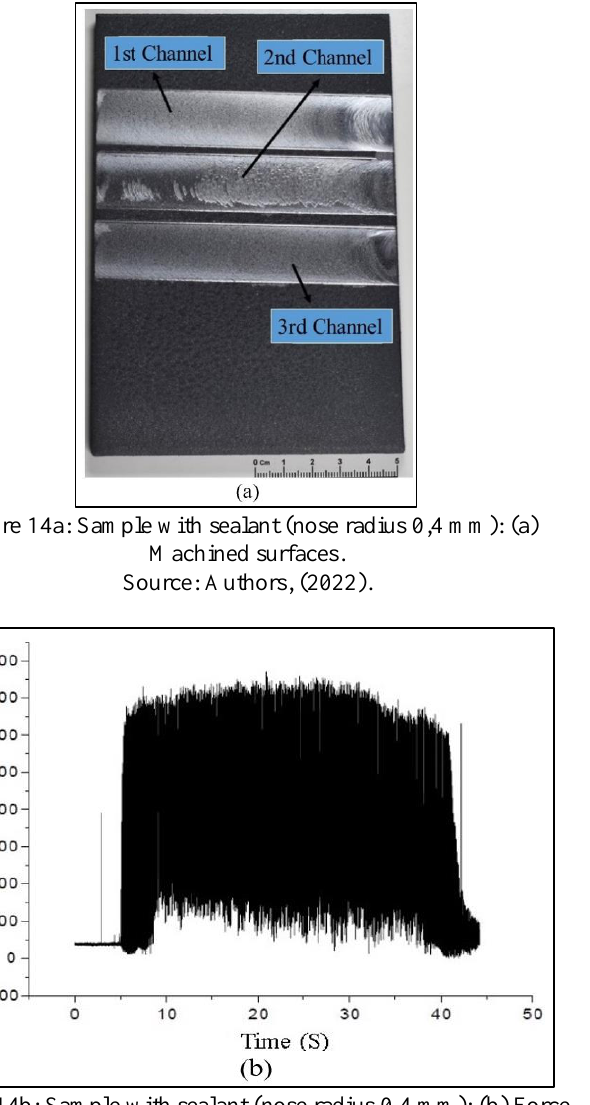
Figure 14b: Sample with sealant (nose radius 0,4 mm): (b) Force spectrum (3rd channel). Source: Authors, (2022).